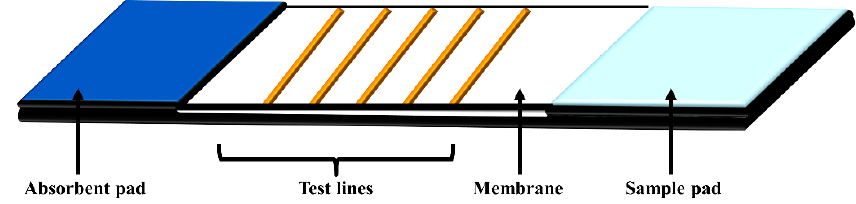
Figure 18. Schematic representation of signal amplification by branched DNA signal amplification technology.